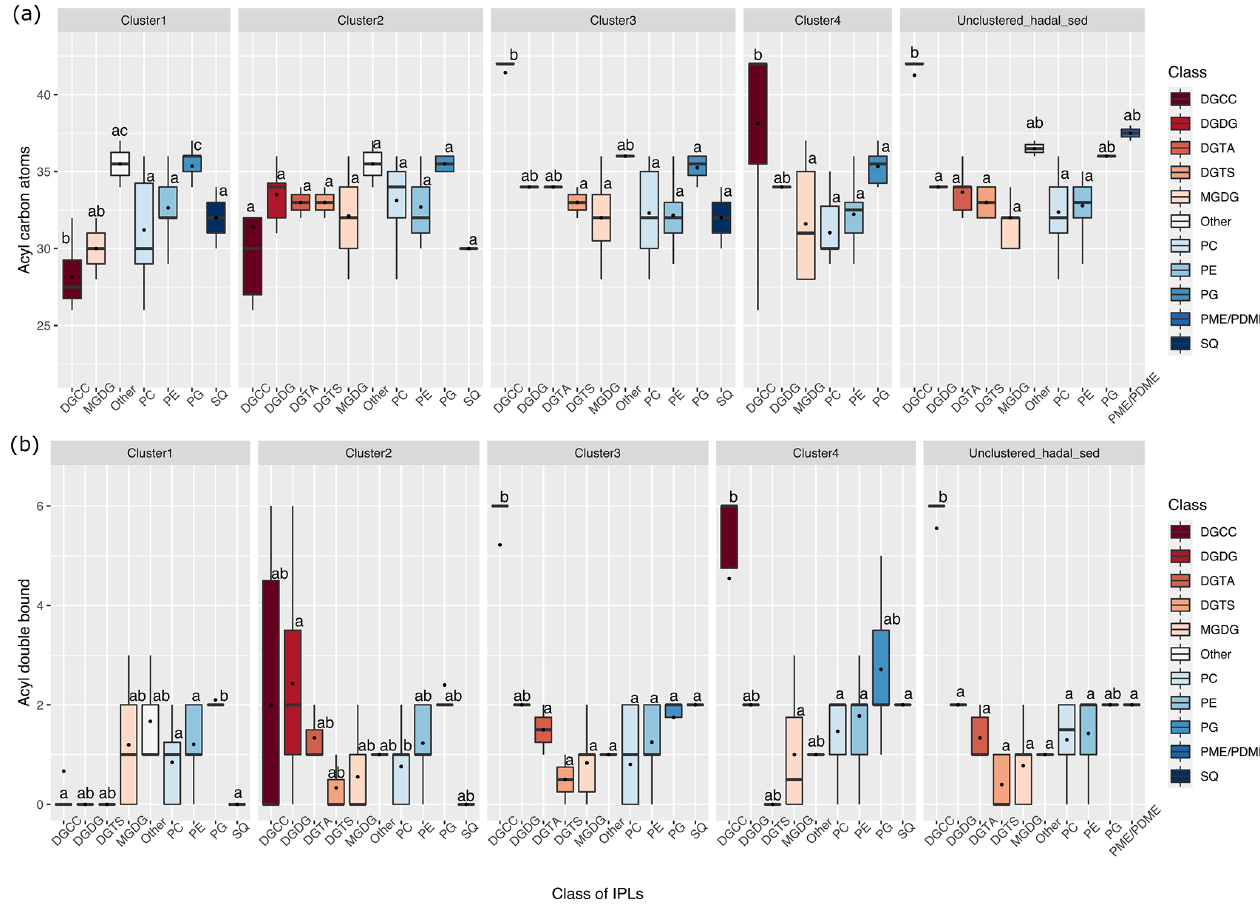
Figure 4. Total number of acyl carbon atoms (a) and acyl double bonds (b) in IPL classes across the distinct clusters shown in Fig. 2. The letters “a” and “b” indicate the presence of statistically distinct groups ( p< 0 . 05) from both ANOVA and post hoc Tukey HSD tests,